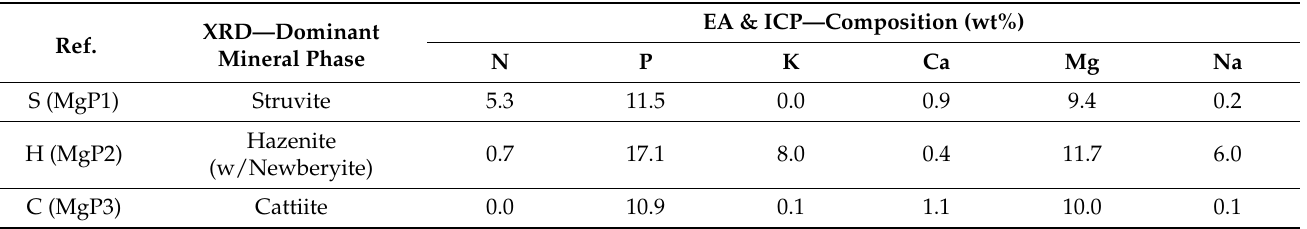
Table 3. Main compositional characteristics of the magnesium phosphate (MgP) products used as draw solution (DS) in the forward osmosis (FO)